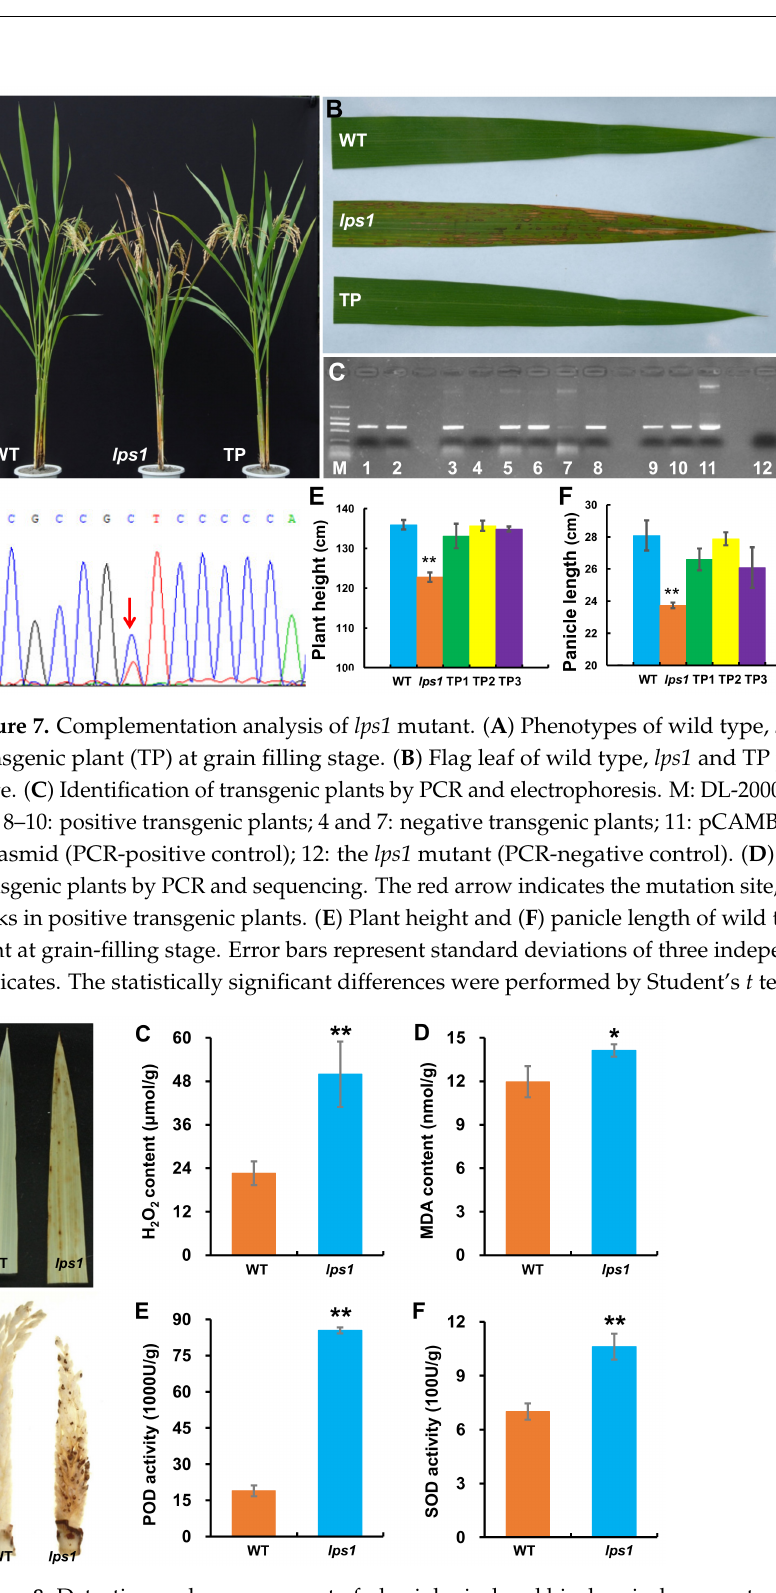
Figure 8. Detection and measurement of physiological and biochemical parameters associated with senescence. ( A , B ) 3,3 (cid:48) -diaminobenzidin (DAB) staining of leaves and young panicles, respectively. ( C ) H 2 O 2 content. ( D ) Malondialdehyde (MDA) content. ( E ) Peroxidase (POD) activity. ( F ) Superoxide dismutase (SOD) activity. Error bars represent standard deviations of three independent biological replicates. The statistically significant differences were performed by Student’s t test. * p < 0.05 and ** p <